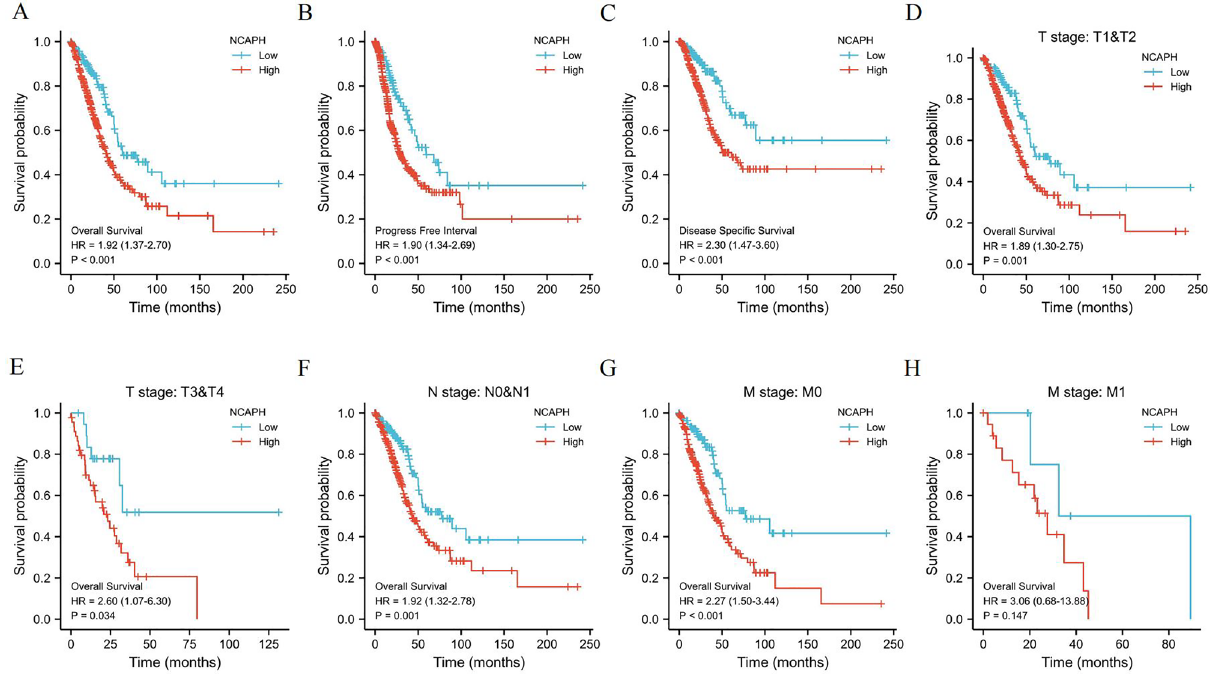
Figure 5. Kaplan–Meier survival curves comparing the high and low expression of NCAPH in LUAD. ( A )–( C ) Survival curves of OS, PFI and DSS between NCAPH-high and -low patients with LUAD. ( D )–( H ) OS survival curves between NCAPH-high and -low patients with LUAD in T1&T2, T3&T4, N0&N1, M0 and M1 sub- group. OS, overall survival; DSS, disease specific survival; PFI, progression free